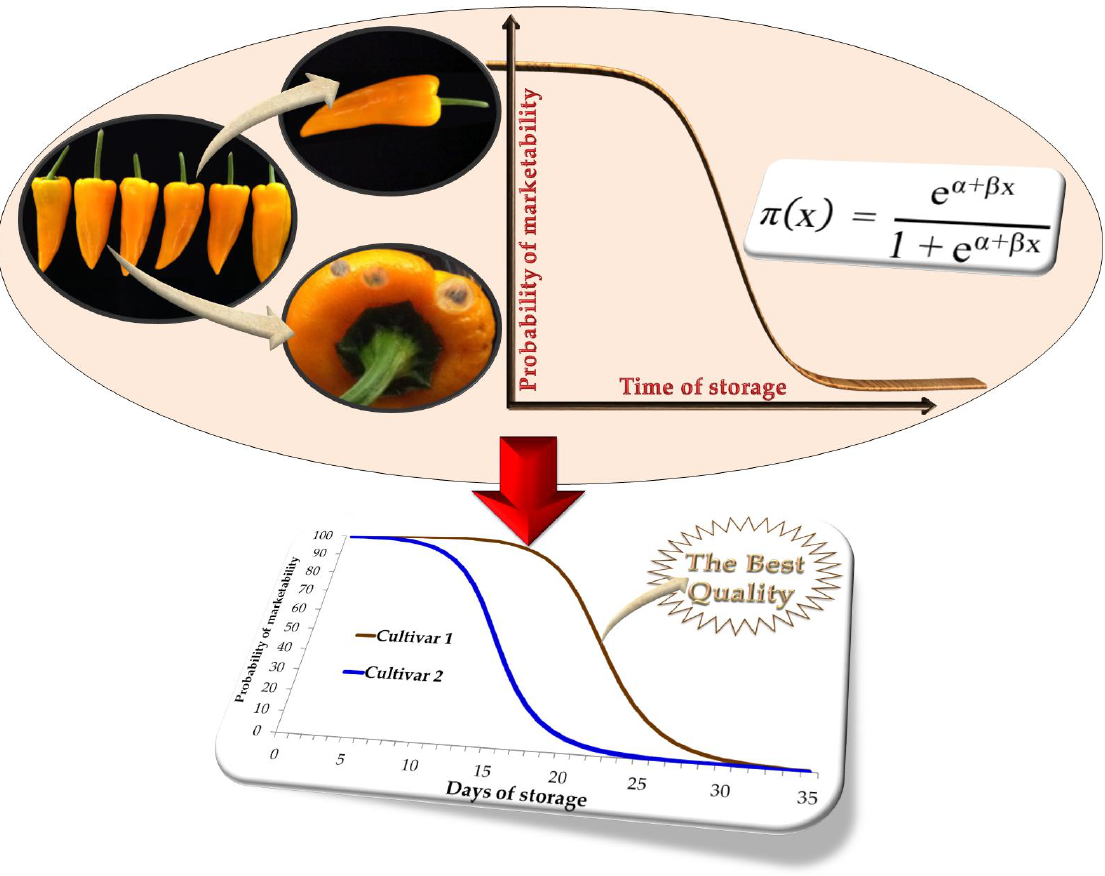
Figure 1. Rationale for the application of binary logistic regression models to evaluate the probability of marketability in pepper cultivars. π ( x ) is the probability of marketability of the fruit, “ x ” is the number of days of storage, “e” is the Euler number, and “ α ” and “ β ” are the intercept and slope of the model, respectively.